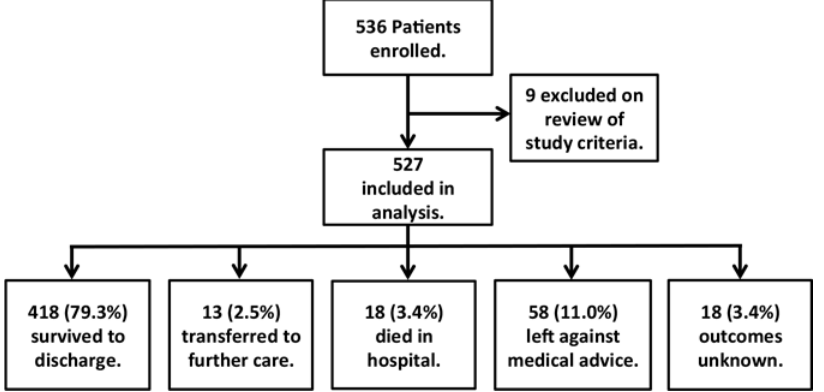
Fig 1. Study participants and admission outcomes, from September 2011 to September 2012. Limited admission record-keeping prevented ascertainment of the total number of eligible patients during the study period.